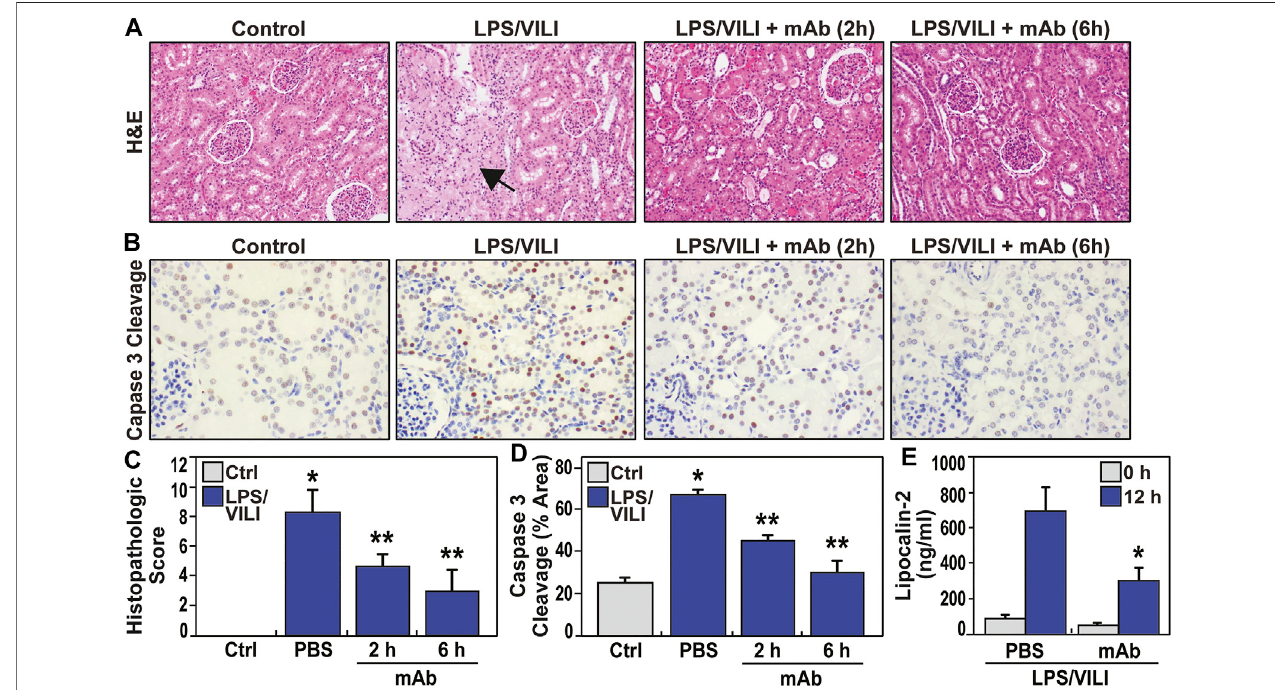
FIGURE4| eNAMPTALT-100mAbtreatmentattenuatesacutekidneyinjury(AKI)inLPS/VILIporcinemodel. (A,C) RepresentativeH&ErenalhistologyinLPS/VILI- exposed minipigs showing marked tubular duct dilation accompanied by areas of frank parenchymal necrosis (arrow) compared to control, unchallenged pigs. Animals receiving the ALT-100 mAb (2 h or 6 h after injury initiation) exhibited dramatic preservation of tissue architecture with minimal evidence of renal injury (* p < 0.05 control vs. untreated LPS/VILI; ** p < 0.05 mAb LPS/VILI vs. untreated LPS/VILI). (B,D) Representative IHC image ofcleaved capase-3 (CC3, marker of apoptosis) in renal tissues from PBS- and ALT-100 mAb-treated pigs at 12 h showing prominent increases in apoptosis in renal tissues. Pigs receiving the eNAMPT mAb (2 h or 6 h after initiation) showed dramatically reduced caspase 3 cleavage staining. (E) LPS/VILI exposure signi fi cantly increases plasma lipocalin levels at 12 h (AKI marker) which are signi fi cantly reduced in ALT-100 mAb-treated pigs (2 and 6 h